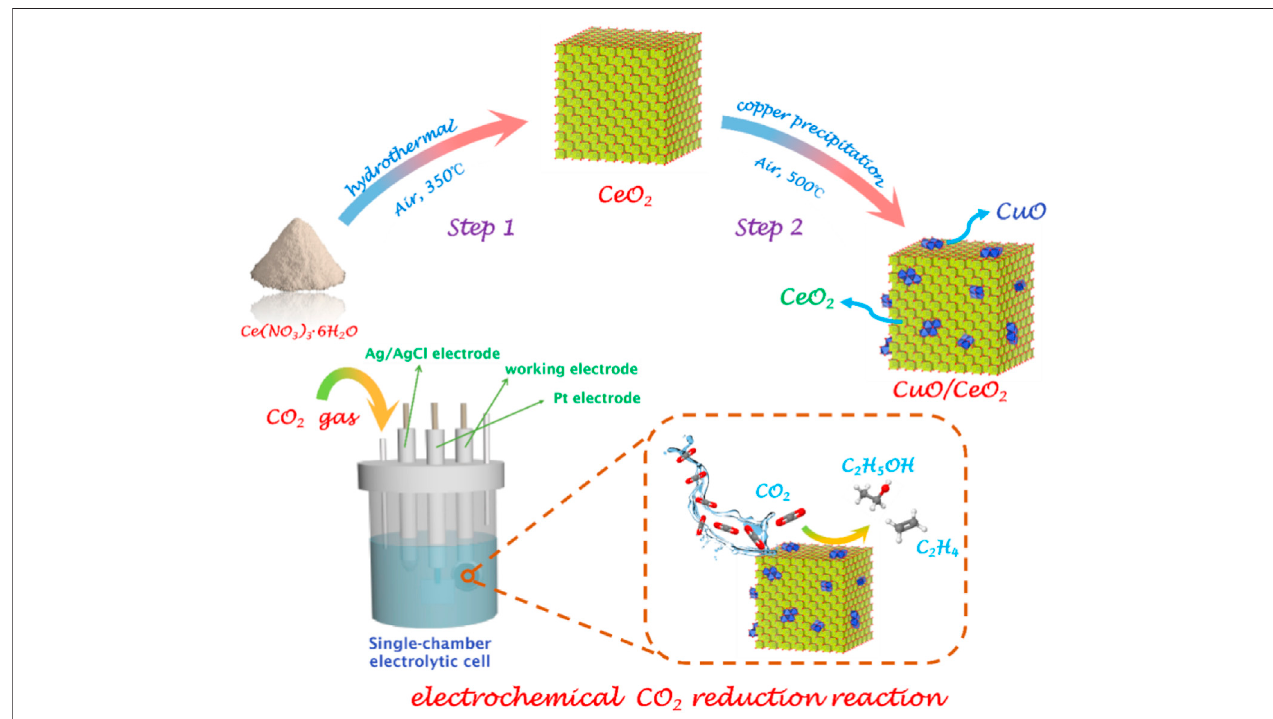
FIGURE 1 | Illustration of the synthesis of CeO